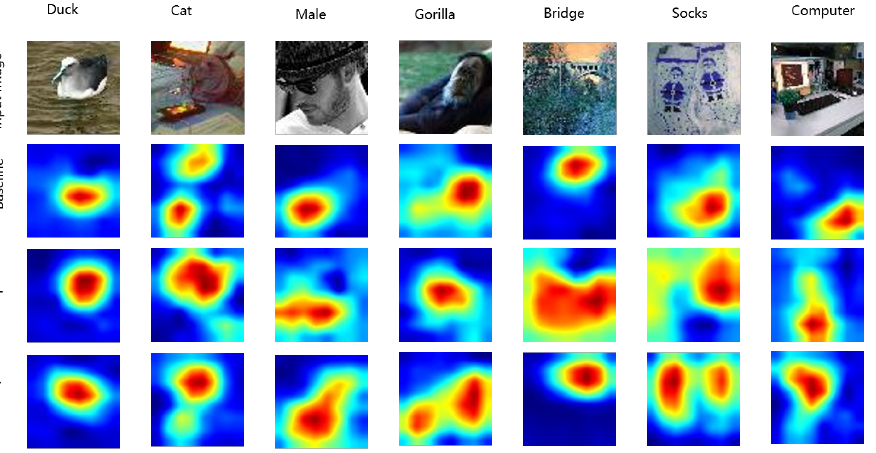
Figure 5. Class activation mapping (CAM) [45] for ResNet-110 model trained without any method, trained with DropBlock, and trained with FocusedDropout. The model trained with our method can accurately identify the target’s location and